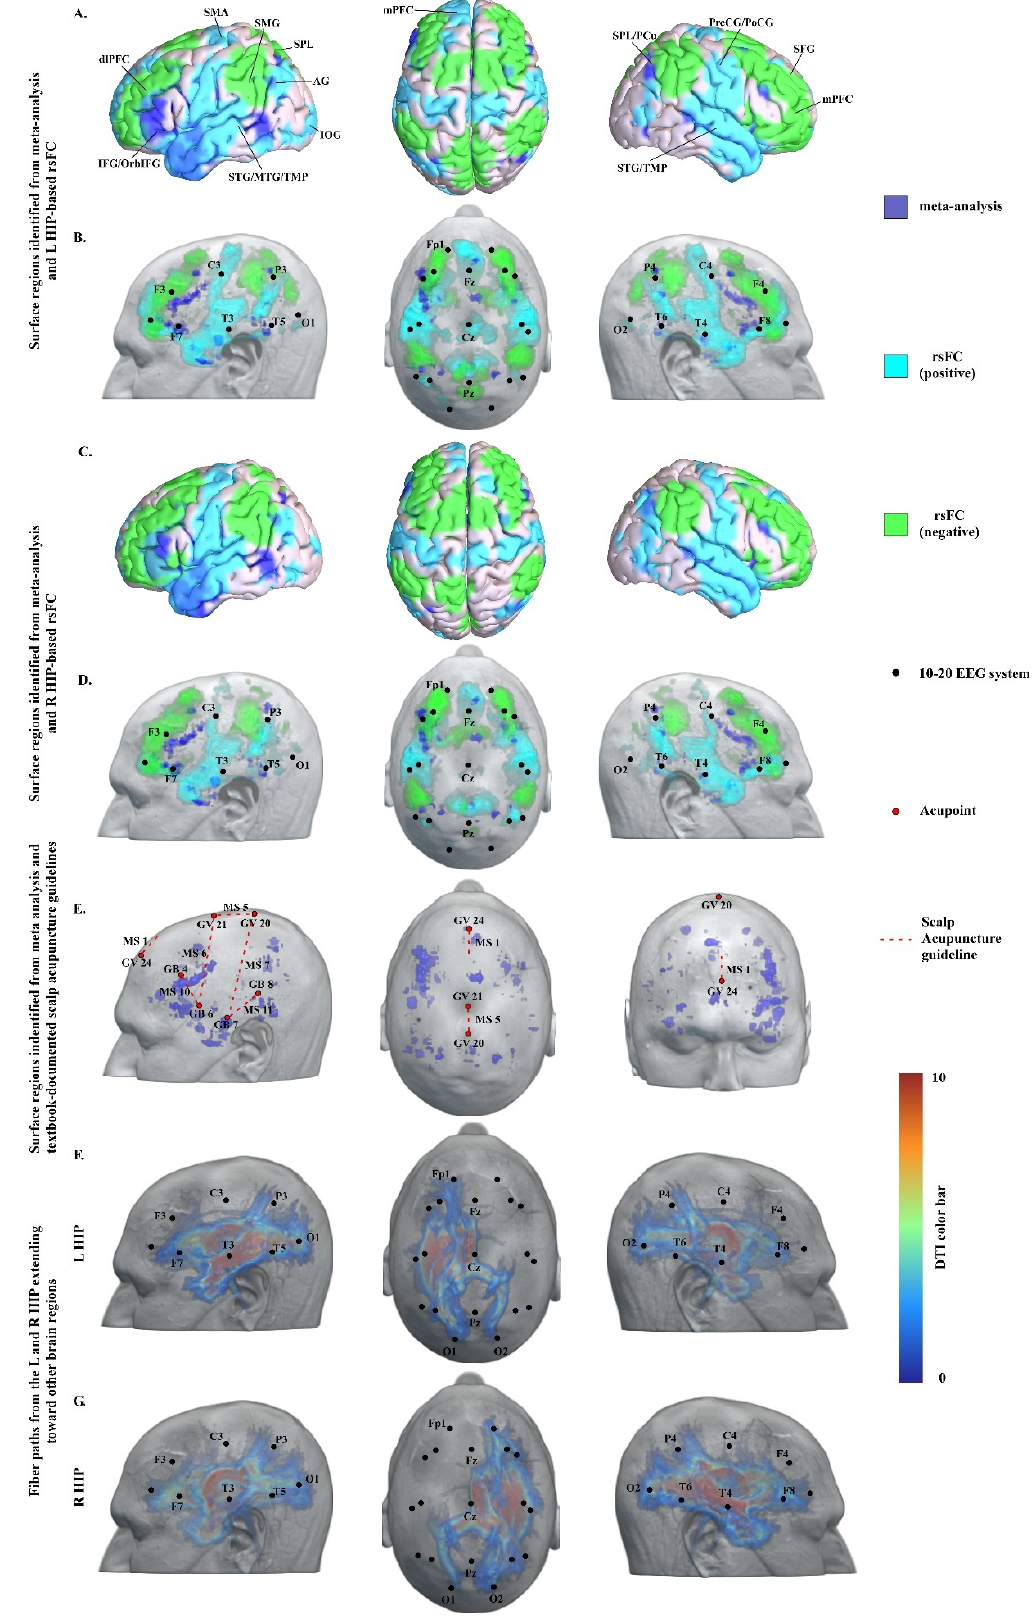
Figure 1. Potential targets for scalp stimulation for dementia identified from imaging study and acupuncture guidance. ( A , B ) Surface regions identified from meta-analysis and L HIP-based rsFC. ( C , D ) Surface regions identified from meta-analysis and R HIP-based rsFC. ( E ) Surface regions identified from meta-analysis and textbook-documented scalp acupuncture guidelines. ( F , G ) Fiber